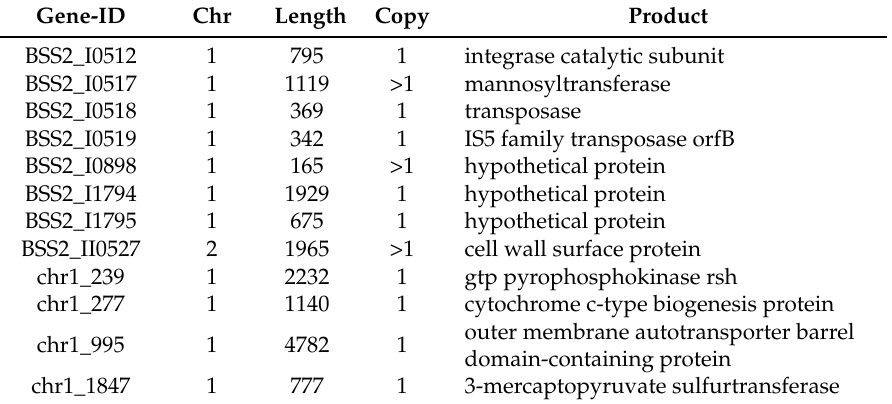
Table 2. Significant different genes between B. suis 019 and S2.